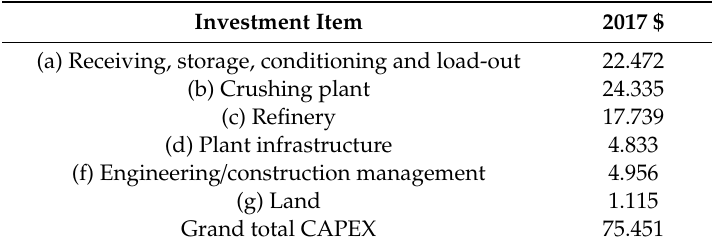
Table 3. Capital expenditures (CAPEX) for a pennycress crushing / refining facility.